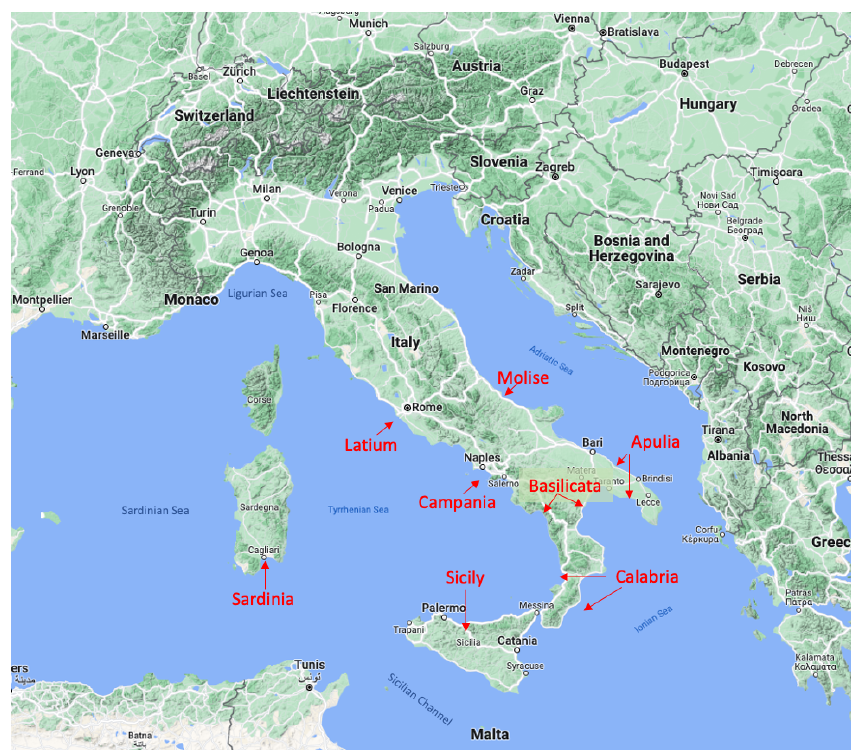
Figure 2. Map data modified from © Google Maps 2022. Map of surveyed Italian coasts and corresponding seas.